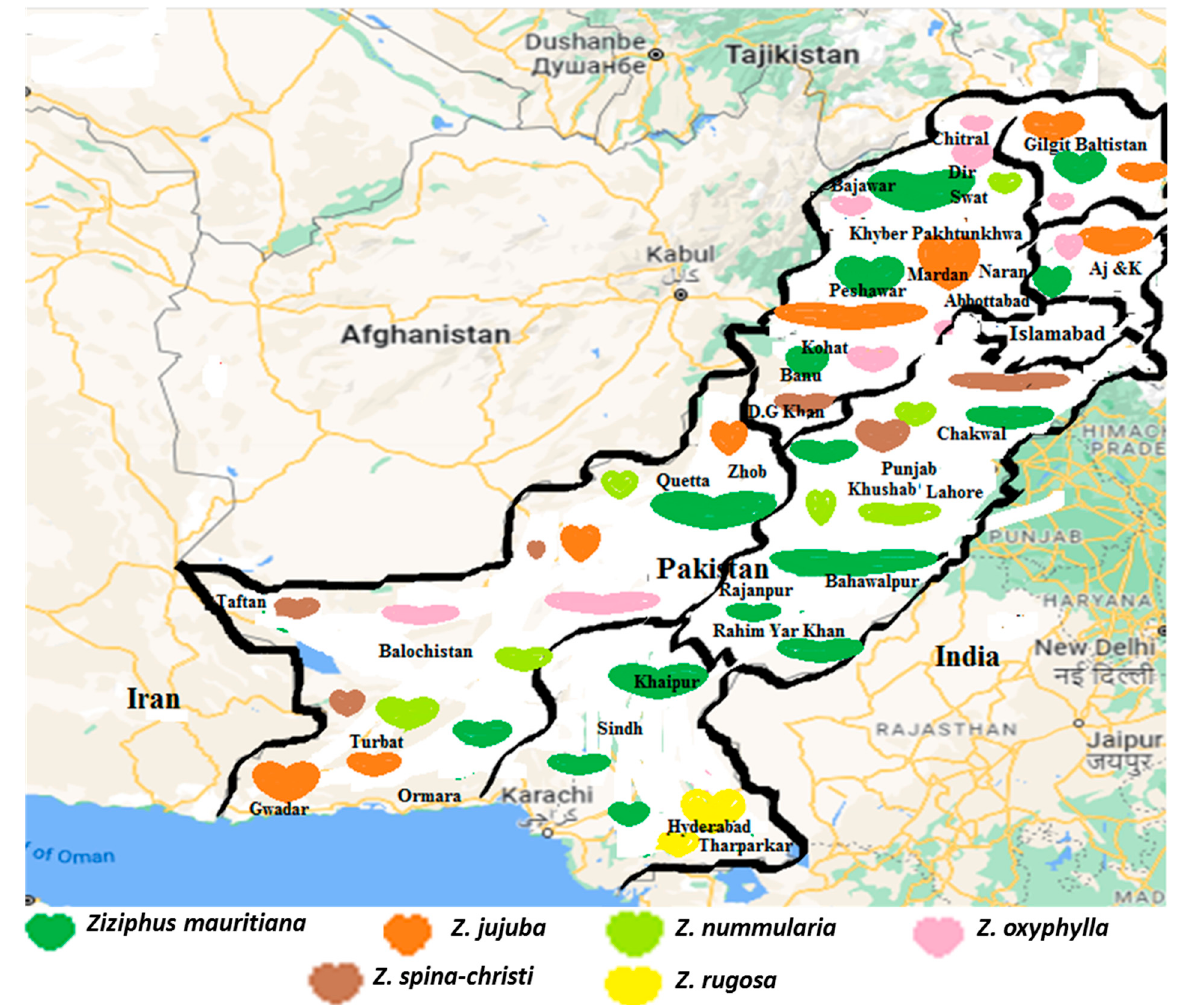
Figure 4. Map of Pakistan representing the locality of different Ziziphus species. The picture was taken from Google Earth and has been edited manually. These different colors show the localities of the six mentioned Ziziphus species found in Pakistan.